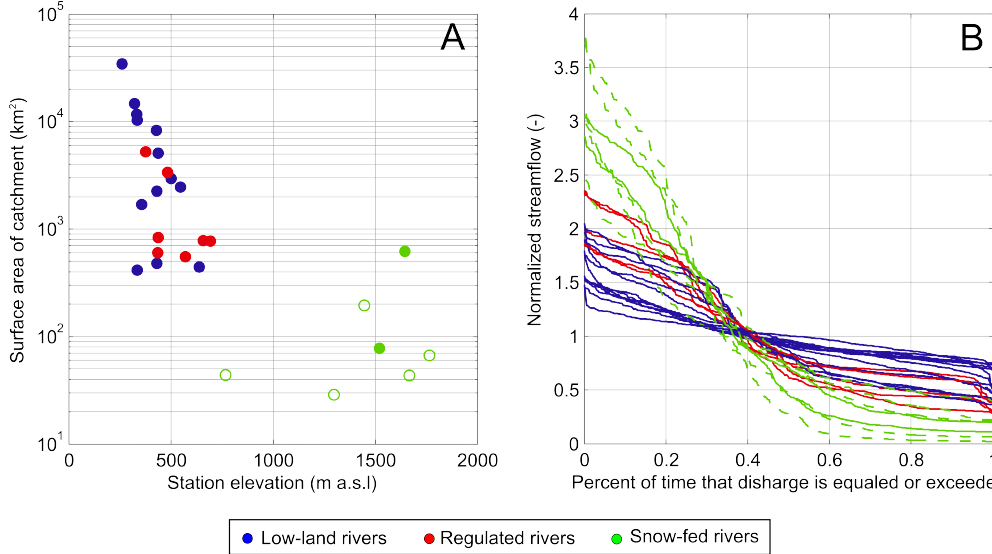
Figure 8. Relationship between river station elevation and upstream catchment surface area ( A ) and flow duration curves ( B ) for the three river categories. Note that flow duration curves are evaluated in terms of normalized streamflow evaluated for the climatological year (each line is represented by 365 points). Empty symbols and dashed lines refer to river stations not used in the heatwave analysis because they have less than 30 years of RWT data (see Table